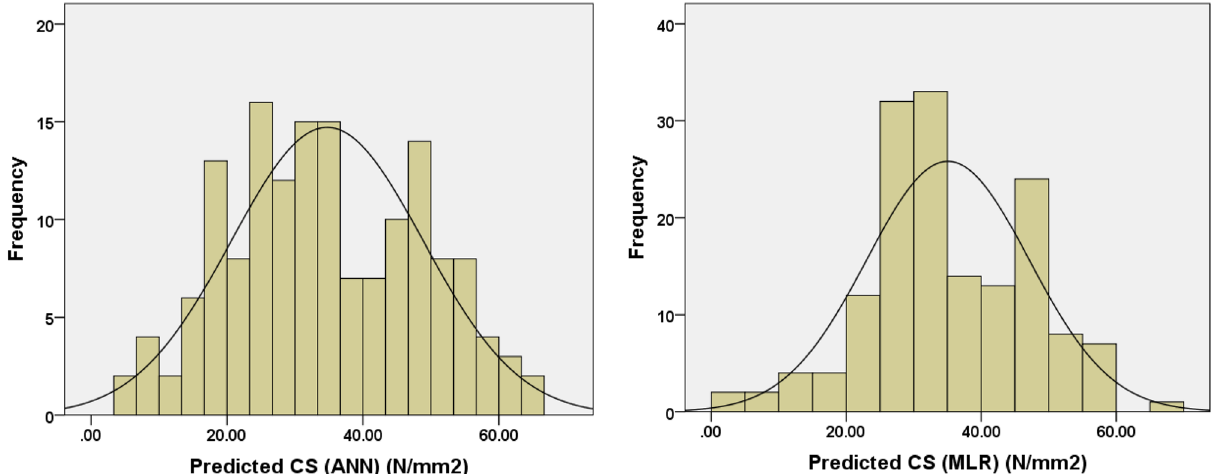
Figure 6. Frequency histograms for the predicted compressive strength (ANN & MLR).